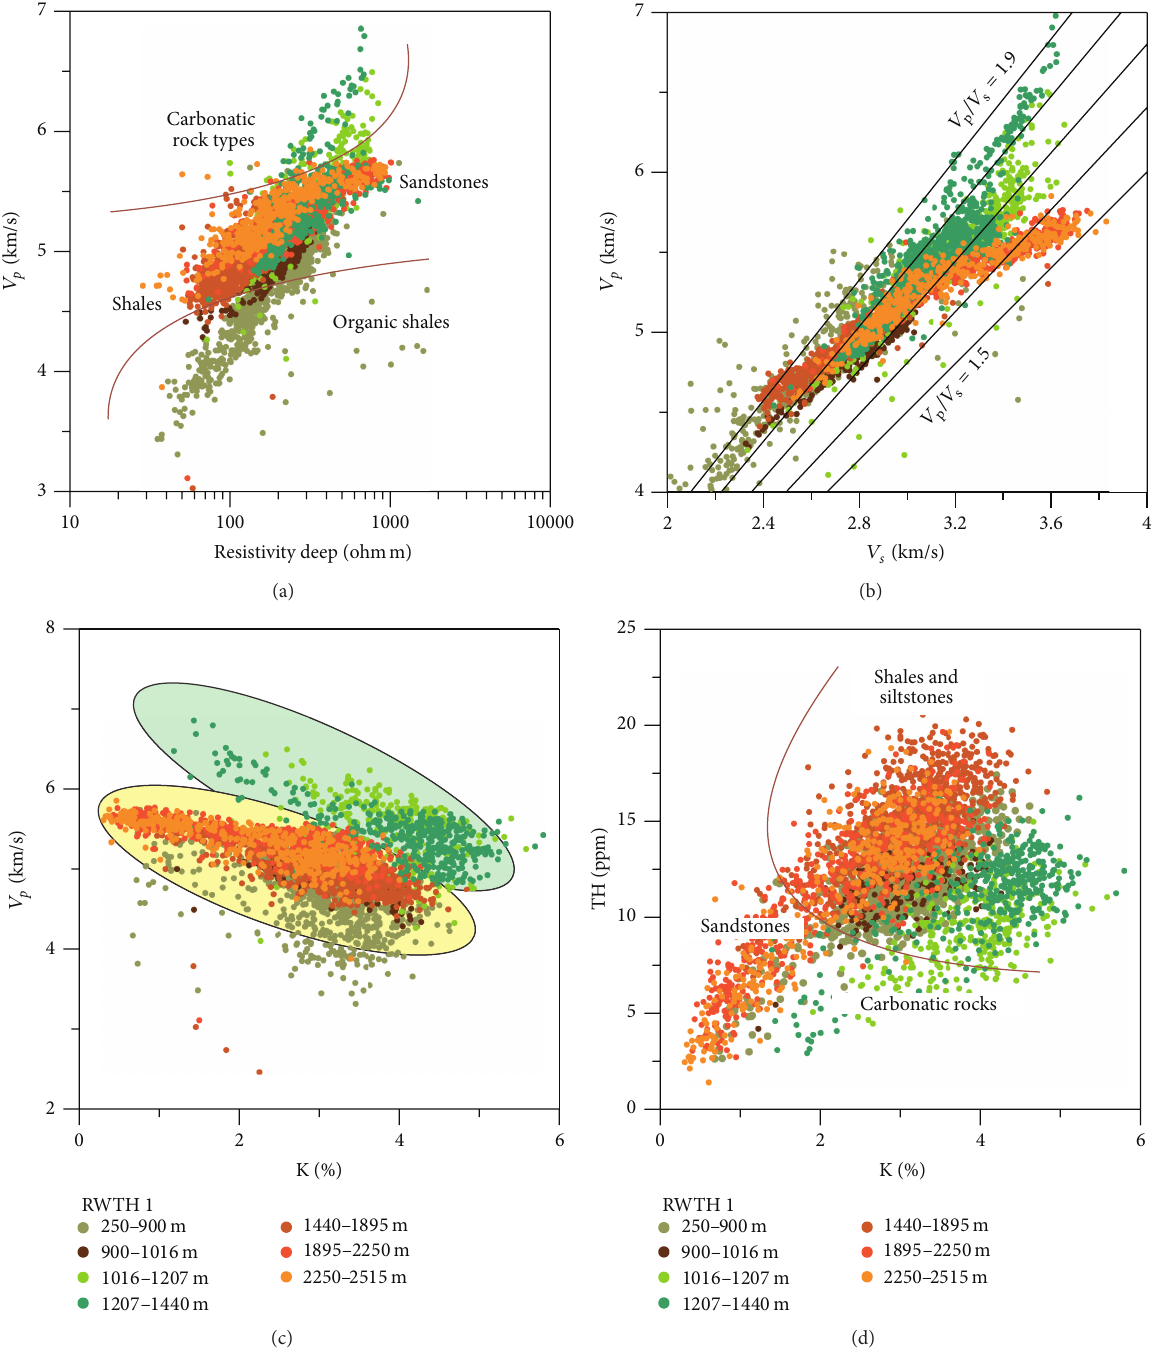
Figure 7: Cross-plots of logging parameter separated for seven depth intervals. Green colours indicate the carbonatic unit (II), which is differing in the log properties from the siliciclastic sediments of unit (I) and unit (III) (brown and orange